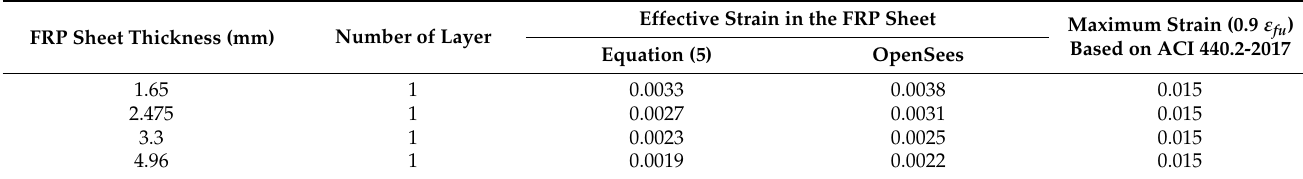
Table 11. Maximum effective FRP strain in web-bonding frames.